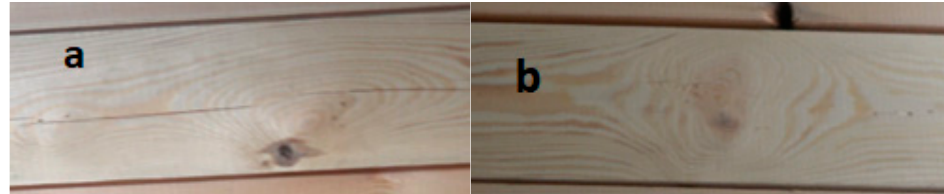
Figure 7. The appearance of critical areas of lumber forming the face of the P34 beam—exterior side of the beam.